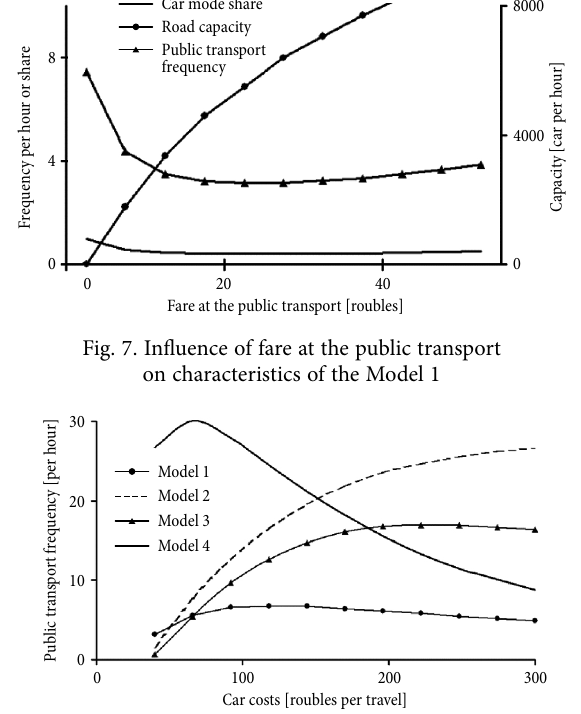
Fig. 2. Influence of value of time on time travelling by car